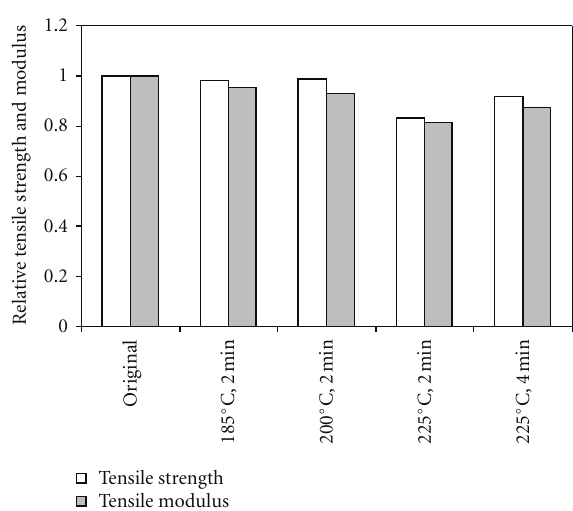
Figure 6: Retention of tensile properties of nanofilms subjected to di ff erent processing